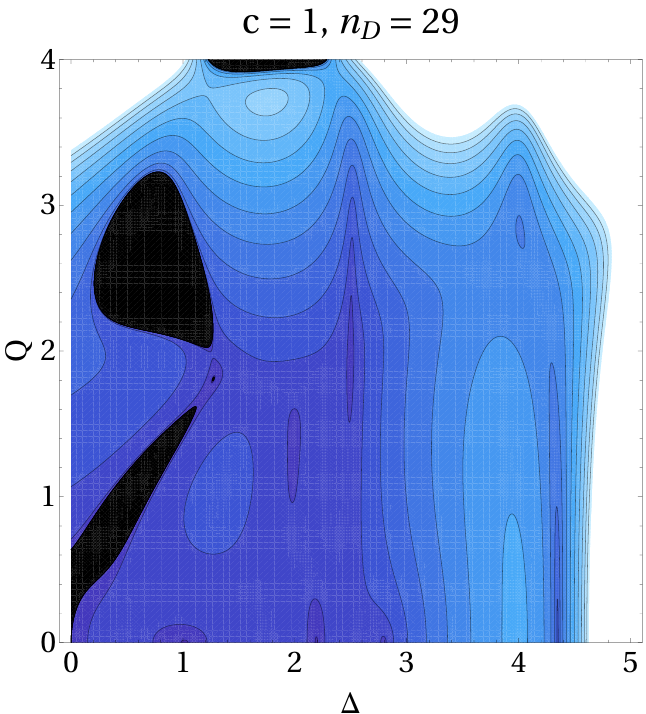
Figure 7 . Projection functional (cid:26) of c = 1 as a function of (cid:1) and Q computed at N = 29. The black regions are where (cid:26) (cid:20) 0; according to our criterion (4.8), (cid:26) is (cid:21) 0 in the allowed region Q (cid:20) 12 r (cid:3) (cid:1) , so the extremal spectrum comprises states where (cid:26) = 0 in this region. There is a line c of small black dots where (cid:26) = 0 along the Q = 0 axis that are di(cid:14)cult to see and so we plot (cid:26) along this line in (cid:12)gure